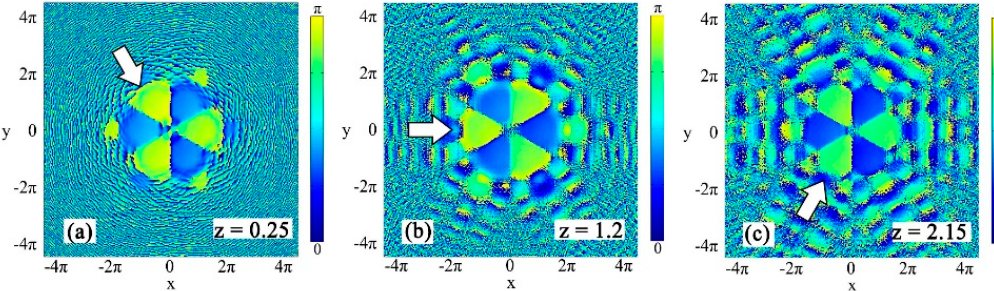
Figure 10. The profile and the phase structures of vortex solitons with different topological charges. 1,2,3 m = . m = topological charges.